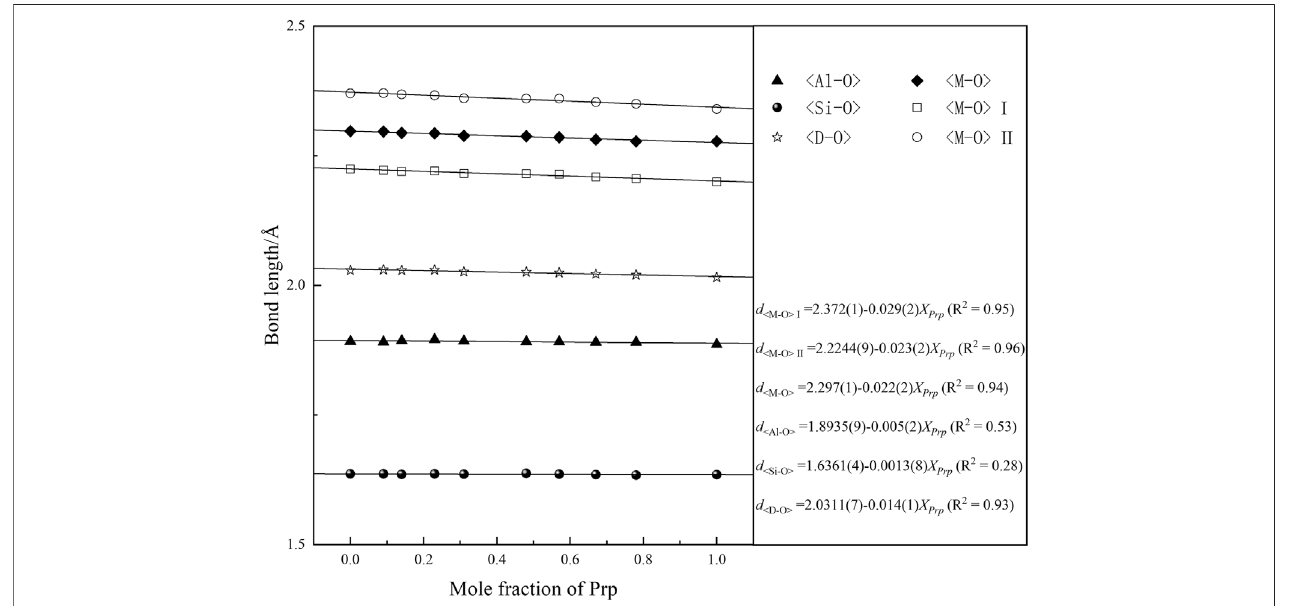
FIGURE 6 | The bond length of the pyrope-almandine solid solution garnet at ambient conditions as a function of pyrope content.